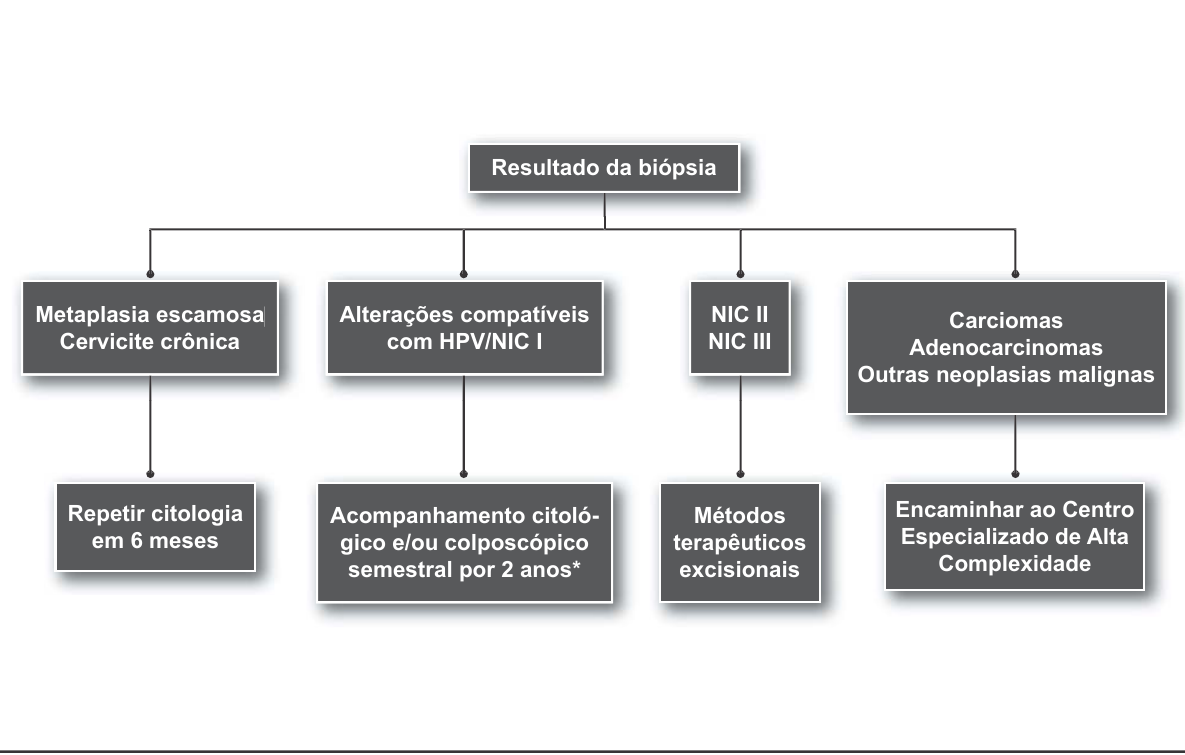
Figura 9 – Recomendações específicas de acordo com o laudo histopatológico Nota t écnica: *Caso haja persistência das alterações citológicas e/ou colposcópicas, está indicada exérese da zona de transformação.